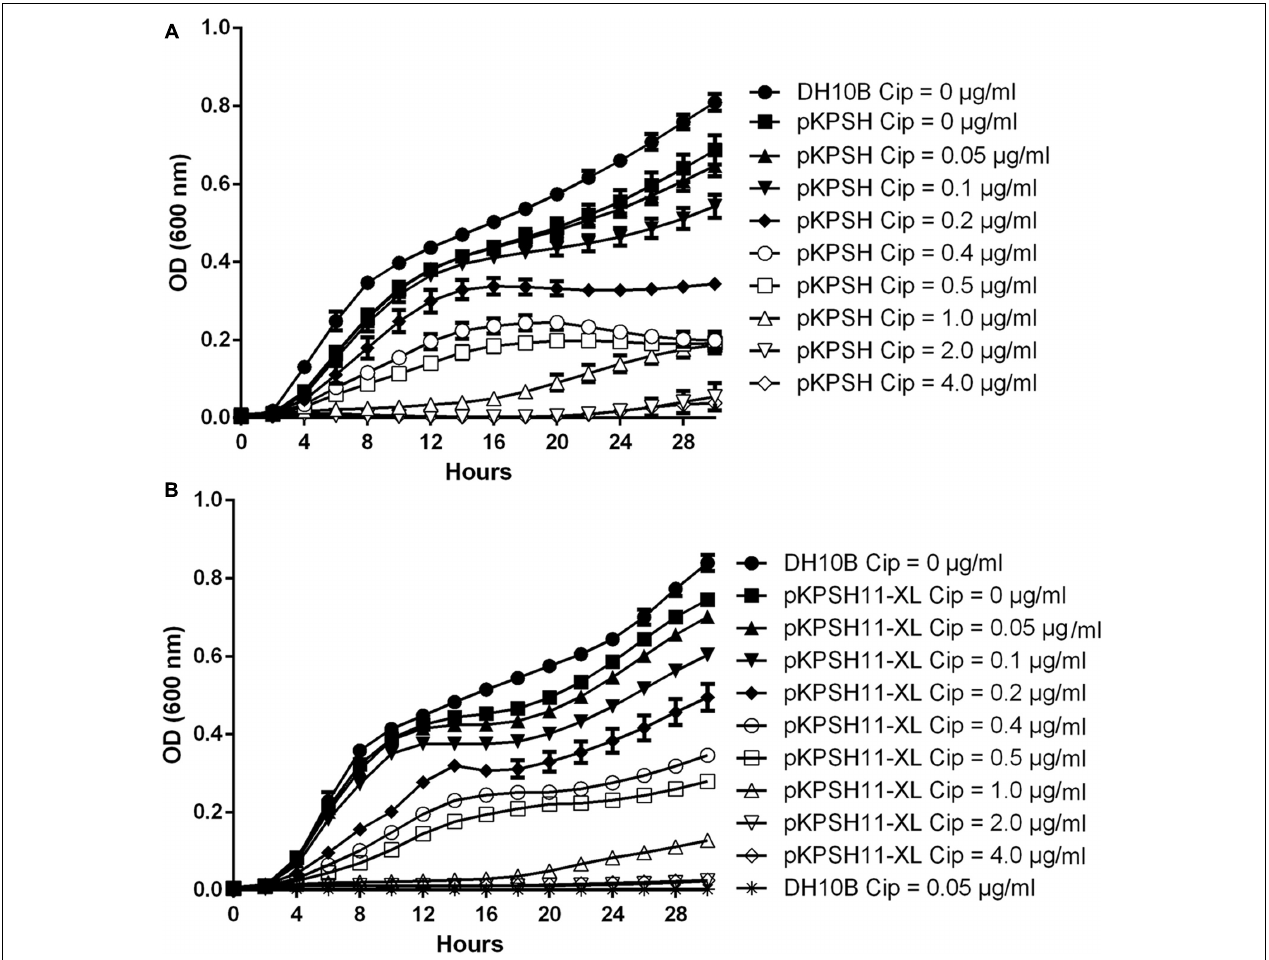
FIGURE 1 | Growth dynamics of qnrS - and qnrB -encoding plasmids in DH10B Escherichia coli electrotransformants exposed to different ciprofloxacin concentrations. Naïve and pKPSH213.55 ( qnrS )-transformed cells (A) . Naïve and pKPSH11-XL ( qnrB )- transformed cells (B) . Plasmid-free DH10B cells did not grow under any of the indicated ciprofloxacin concentrations. Cip -